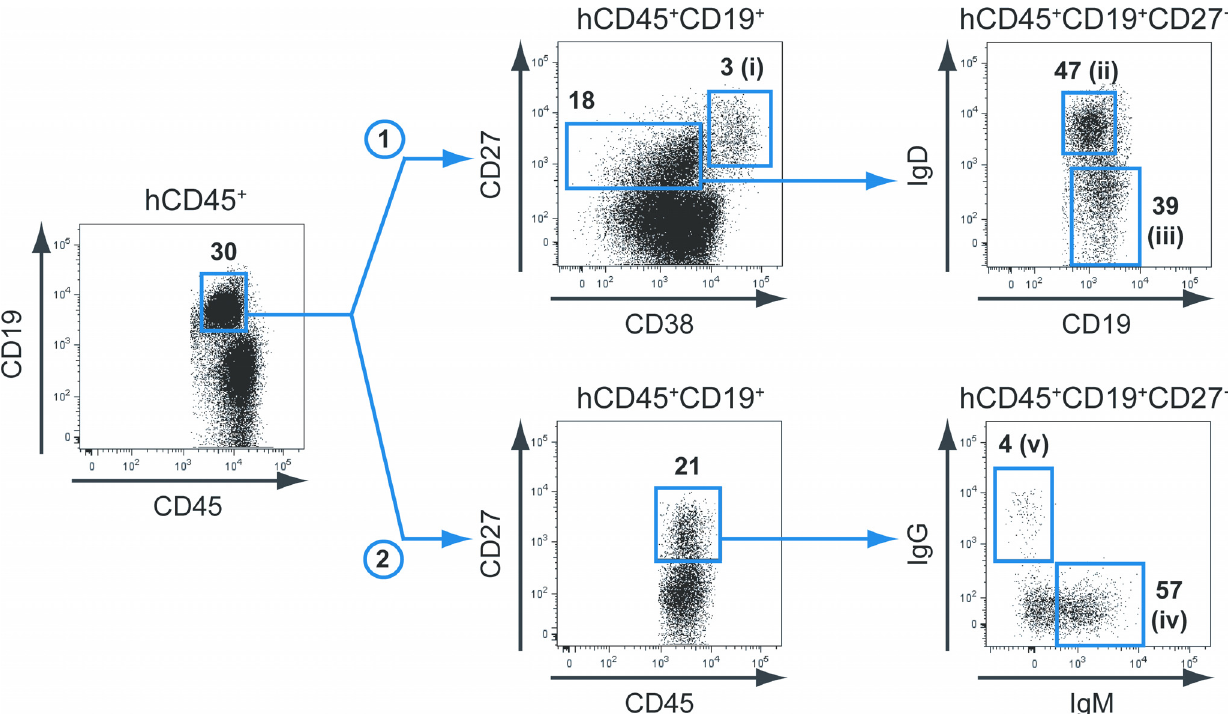
Figure 3. Memory B cell sorting strategies. Subsets of human B cells (CD45 + CD19 + ) were sorted from BM and spleens of vaccinated HIS mice. The strategy 1 (upper part) was used on 3 responder HBsAg-vaccinated animals and gave rise to the following B cell subsets: (i) CD27 hi CD38 hi , (ii) CD27 + CD38 lo/int IgD + , and (iii) CD27 + CD38 lo/int IgD 2 . The strategy 2 (lower part) was used on 3 responder TT-vaccinated animals and gave rise to the following B cell subsets: (iv) CD27 + IgM + IgG 2 , and (v) CD27 + IgM 2 IgG + . The respective frequency and name (from i to v) of each sorted B cell subsets is indicated in the corresponding flow cytometry dot plot. doi:10.1371/journal.pone.0013137.g003 PLoS ONE |